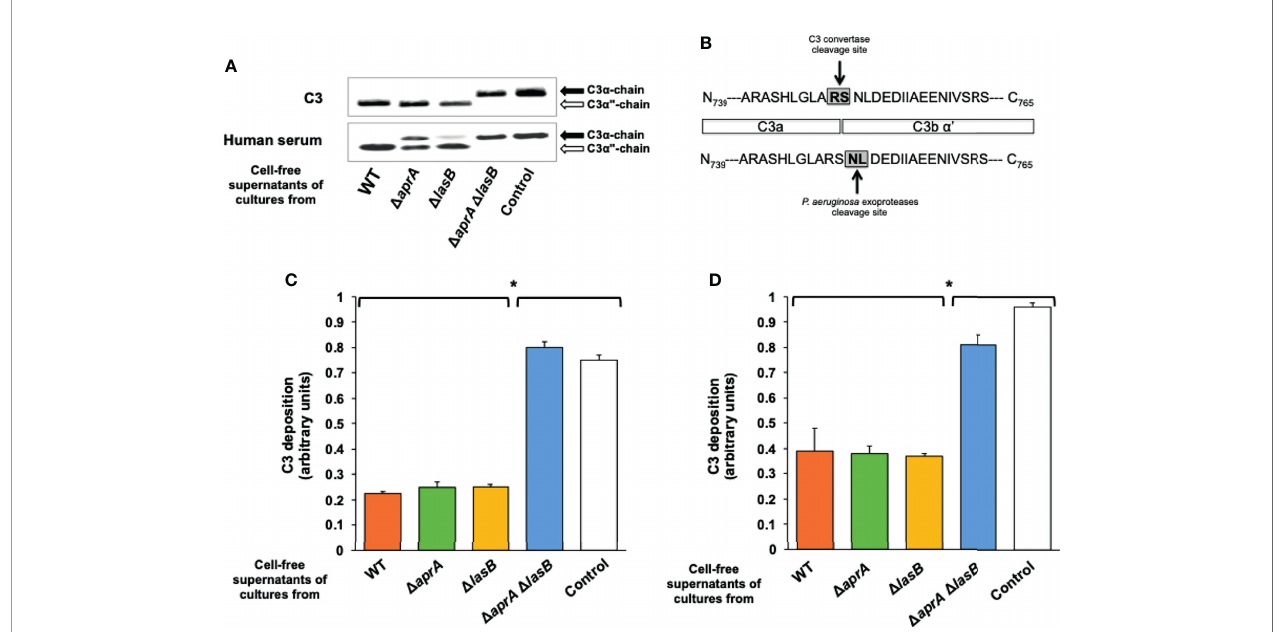
FIGURE 1 | P . aeruginosa exoproteases AprA and LasB cleave C3. (A) Exoproteases AprA and LasB cleave human C3. Representative Western blot analysis of C3 cleavage by P. aeruginosa . Puri fi ed human C3 (300 ng) or human serum (10%) were incubated for 3 h at 37°C with LB (control) or the cell-free supernatants obtained from cultures of the wild-type (WT) P. aeruginosa PA14 and the isogenic de fi cient mutants in AprA ( D aprA) , LasB ( D lasB) or both ( D aprA D lasB ). Proteins were separated by SDS-PAGE and subjected to a Western blot with a rabbit polyclonal antibody anti-C3. Speci fi c cleavage of the C3 a chain (black arrow) resulted in release of a ≈ 100 kDa product, C3 a ” (white arrow). Full-length blots are presented in Supplementary Figure S1 . (B) C3 cleaving site of exoproteases is different to the C3 convertase cleavage site. C3 a ” was subjected to N terminal sequencing. Exoproteases was demonstrated to cleave C3 between Asp 751 and Leu 752 , 2 amino acids downstream to the physiological C3 convertase cleavage site. (C, D) Exoproteases AprA and LasB cleave C3 either soluble or deposited on the bacteria. Analysis of complement component C3 deposition on P. aeruginosa . In C, cells of the wild-type strain PA14 were incubated 1h in human serum pre-treated (1h at 37°C) with the cell-free supernatants of cultures from the wild-type P. aeruginosa PA14 (WT) or from the isogenic de fi cient mutants in AprA ( D aprA) , LasB ( D lasB) or both ( D aprA D lasB ), while in D, cells of the wild-type strain were incubated 1h in human serum, washed and then treated with the cell-free supernatants (2h at 37°C). C3 deposited on the bacterial surface was determined by ELISA. Control values in heat inactivated serum were always < 0.1 arbitrary units and were subtracted from the values obtained with human serum. Data represents three experiments done in duplicate. Errors bars represent SEMs. Statistical analyses were performed using ANOVA with post hoc Tukey; *P <